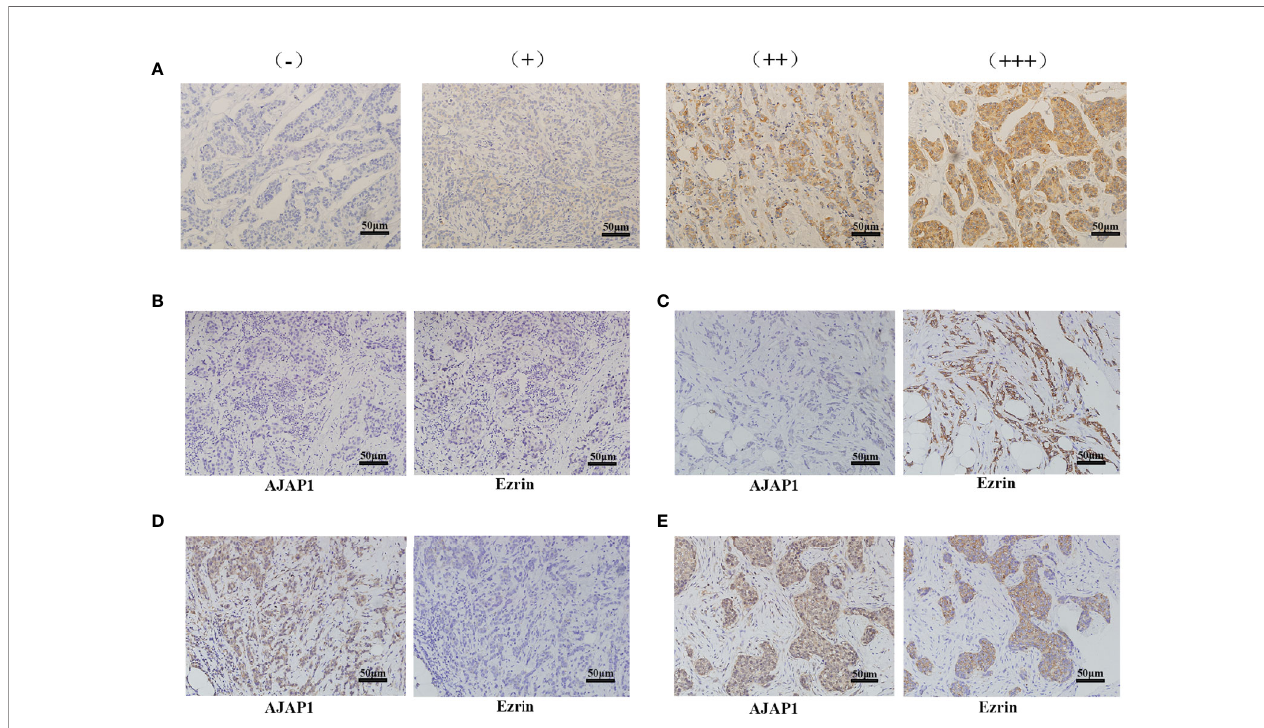
FIGURE 1 | Different expression of Ezrin and AJAP1 in breast cancer. (A) Different staining intensity of Ezrin in breast cancer (×100). (B – E) Series slides of Ezrin and AJAP1 expression in breast cancer tissue slides: (B) AJAP1 negative/Ezrin-negative (×100), (C) AJAP1-negative/Ezrin-positive (×100), (D) AJAP1-positive/Ezrin- negative (×100), (E) AJAP1-positive/Ezrin-positive